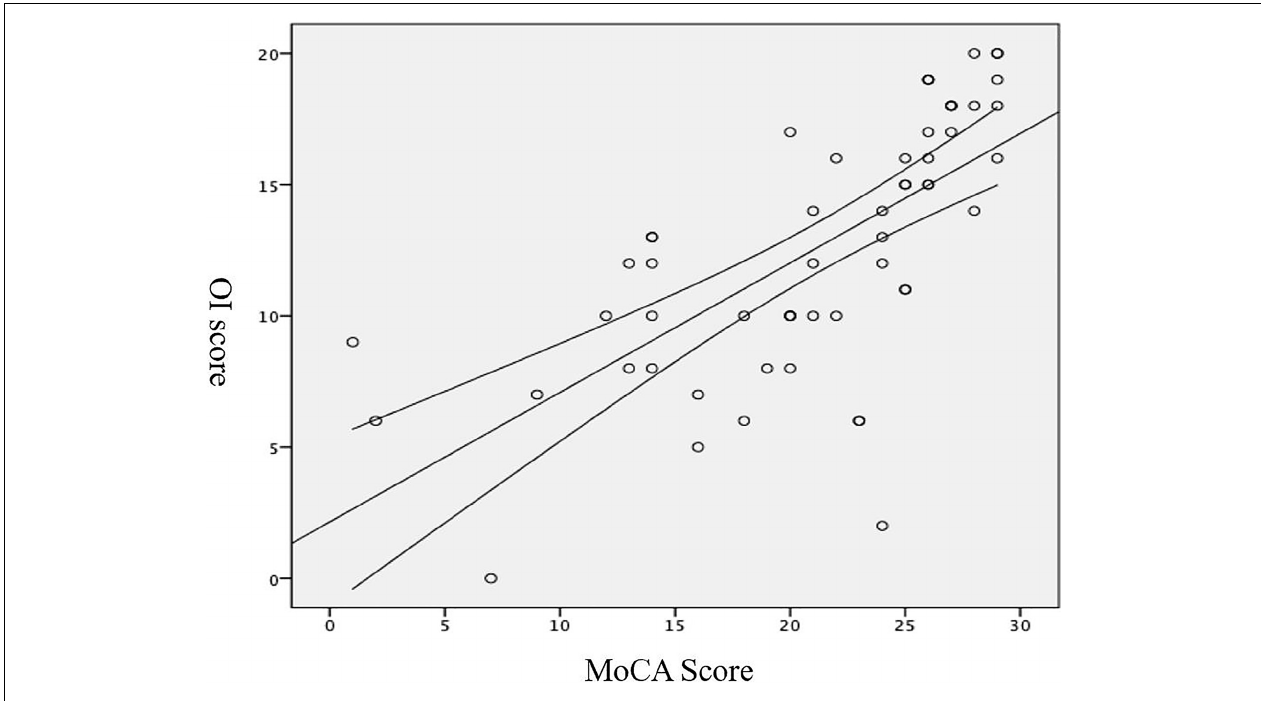
FIGURE 1 | Correlation between the MoCA and OI